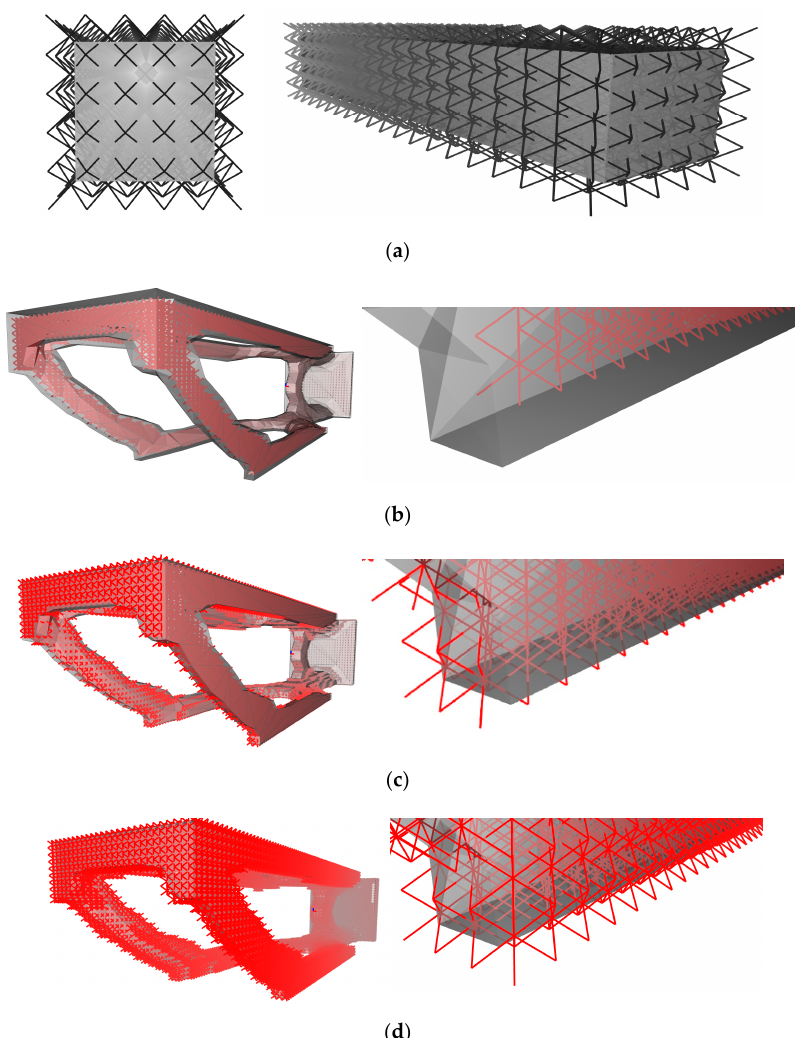
Figure 10. Uniform lattice infill: ( a ) basic concept, ( b ) uniform infill with every unit cell completely represented inside the boundary, ( c ) aligning of the centroid of the cells with the boundary, and ( d ) ensuring the entire structure is completely filled with